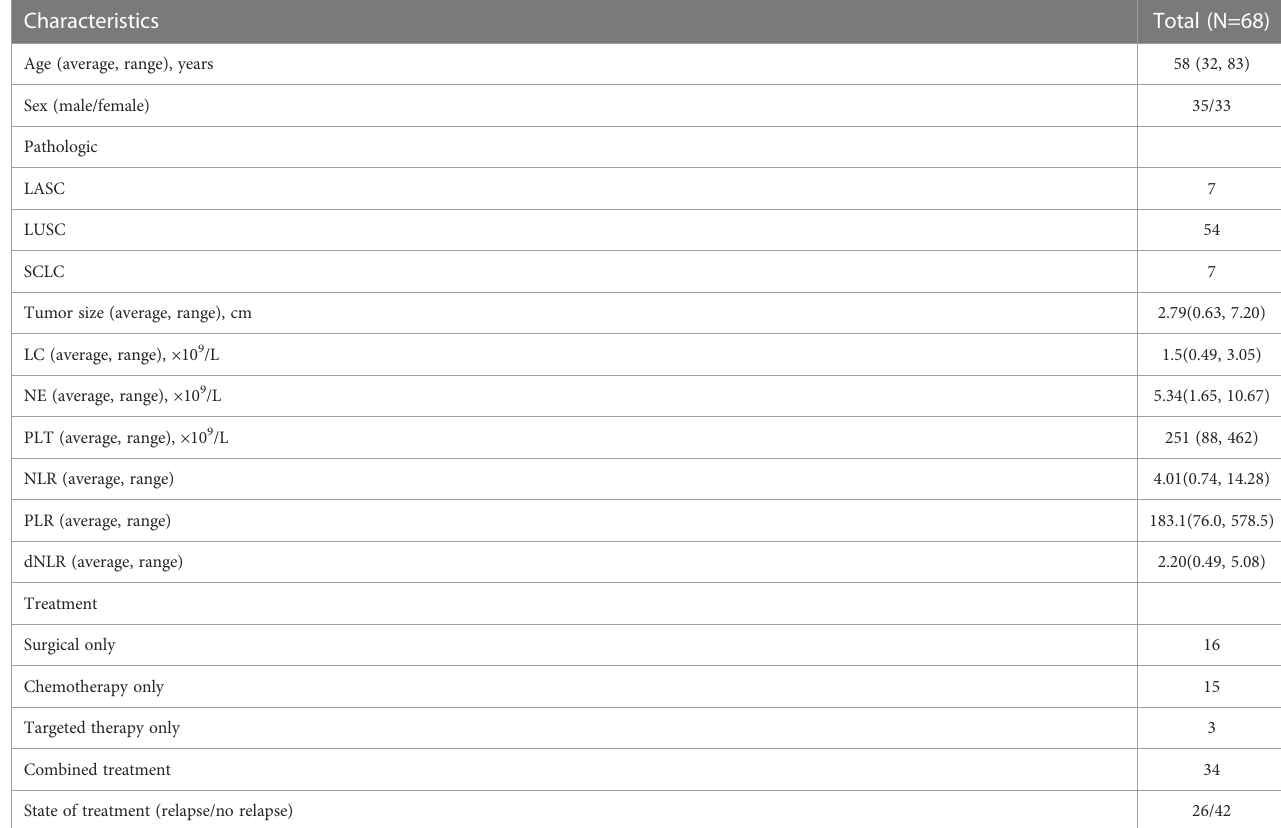
TABLE 1 Clinical and pathological characteristics of the 68